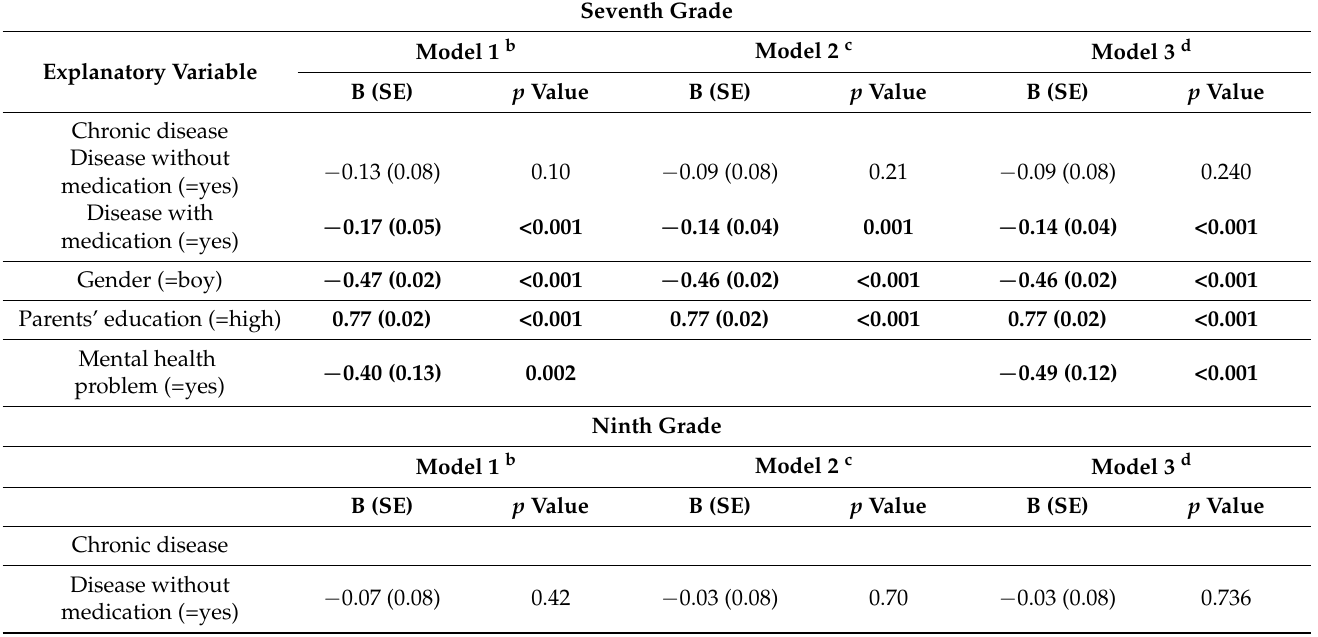
Table 1. The association of chronic disease in the seventh grade ( N = 8960) and in the ninth grade (N = 7394) with the grade point average (GPA a ) in bivariate (Model 1) and adjusted models (Models 2 and 3). Linear regression